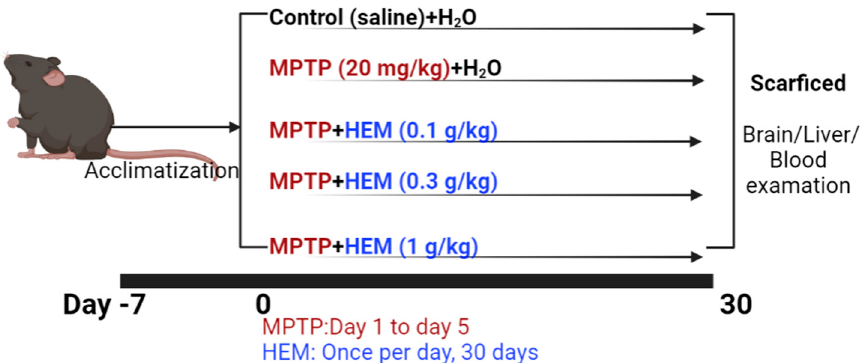
Figure 1. Treatment fl ow chart.